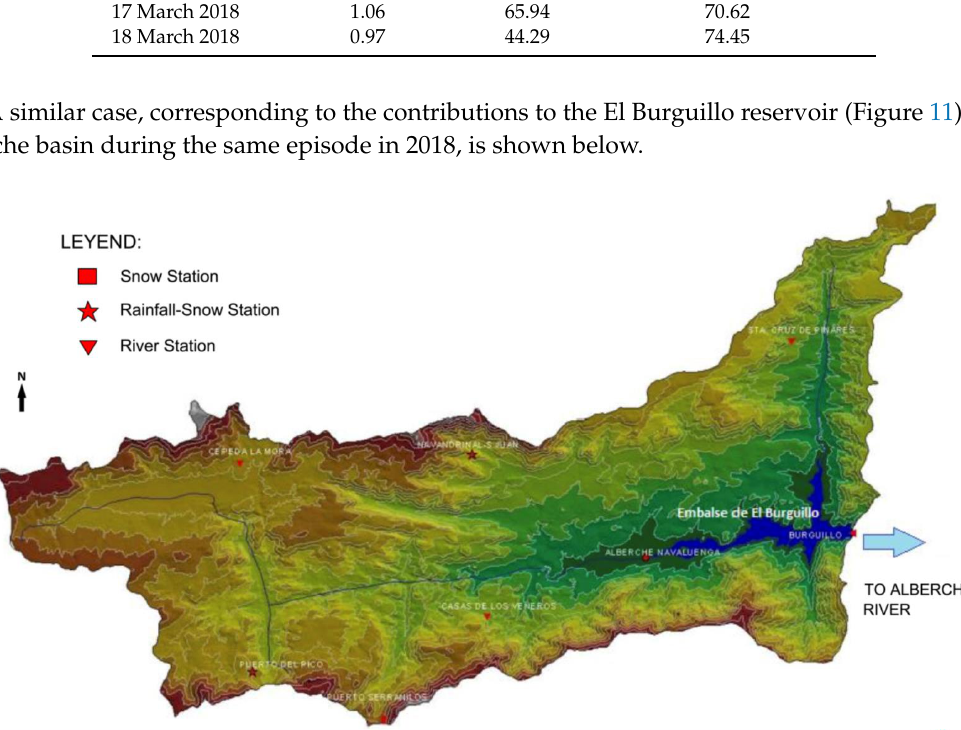
Figure 11. Location of the El Burguillo Reservoir in the upper part of the Alberche